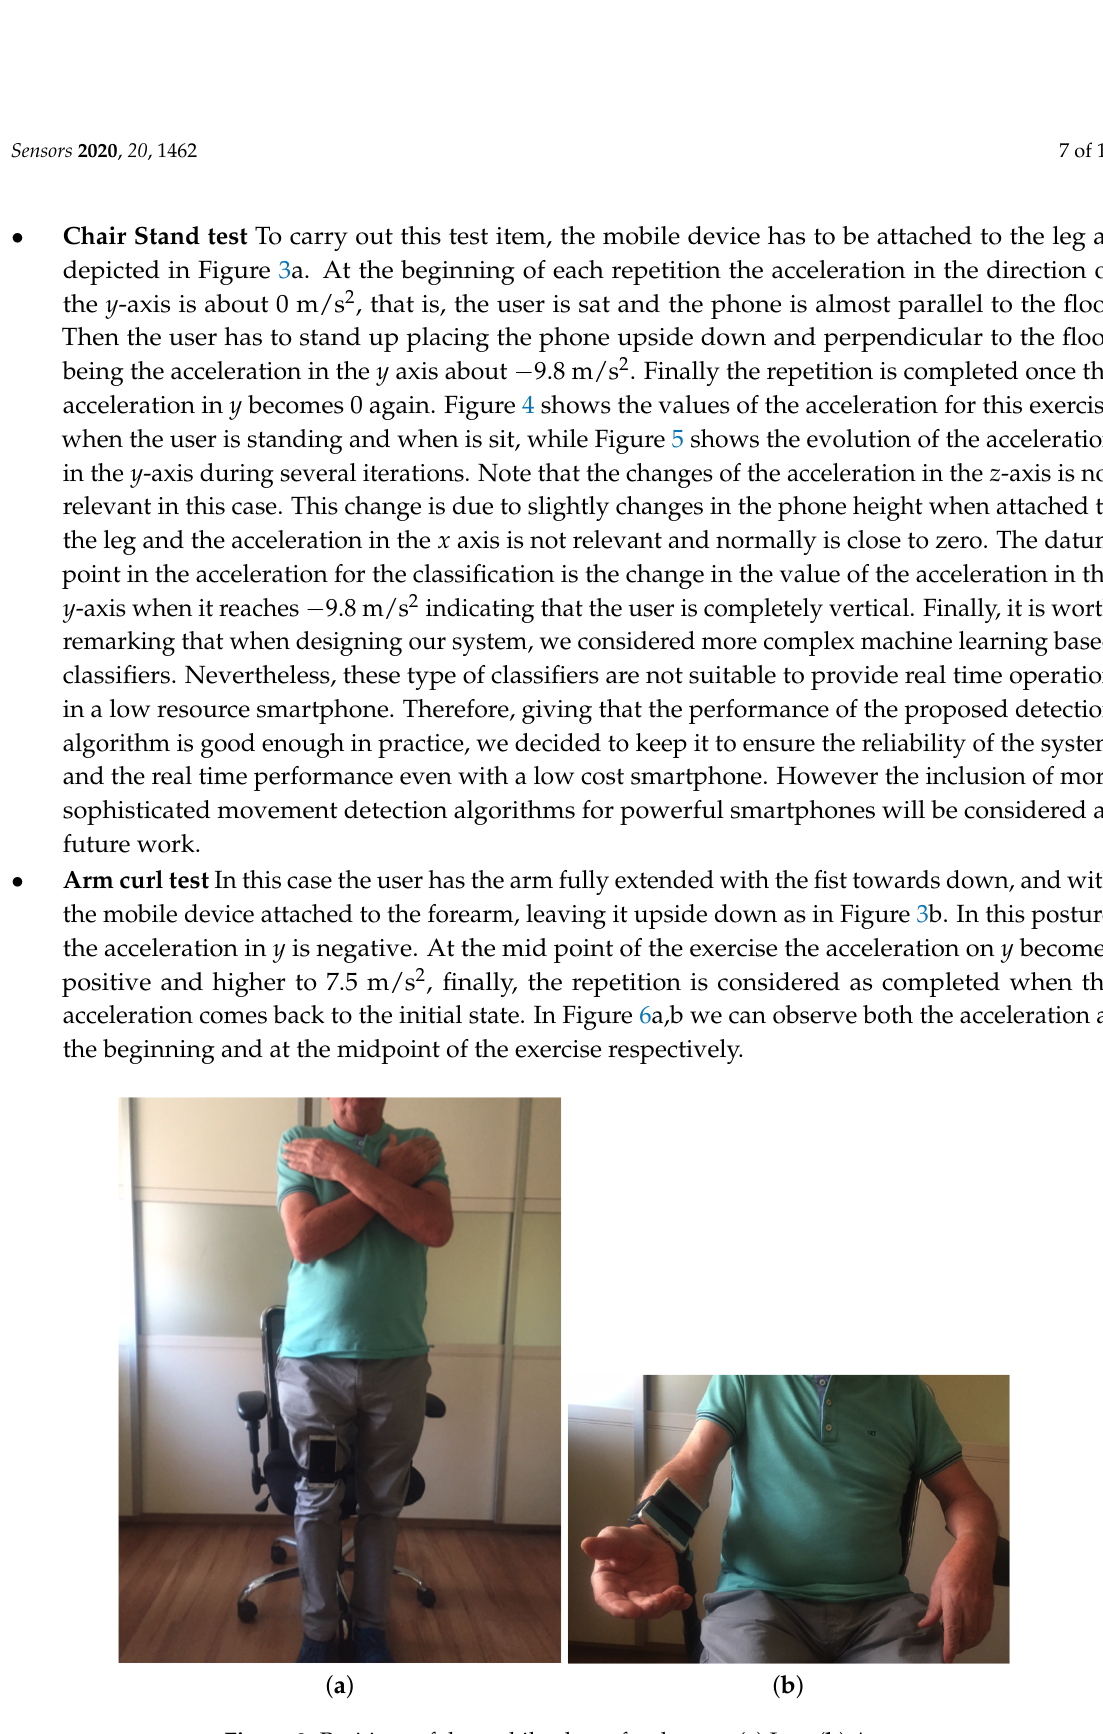
Figure 3. Positions of the mobile phone for the test: ( a ) Leg; ( b )